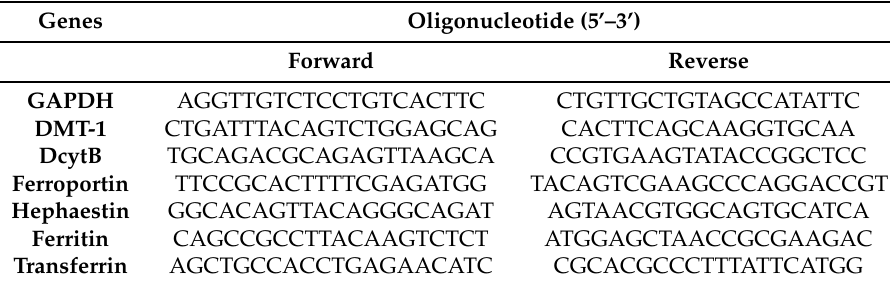
Table 3. Sequence of primers used in the RT-PCR